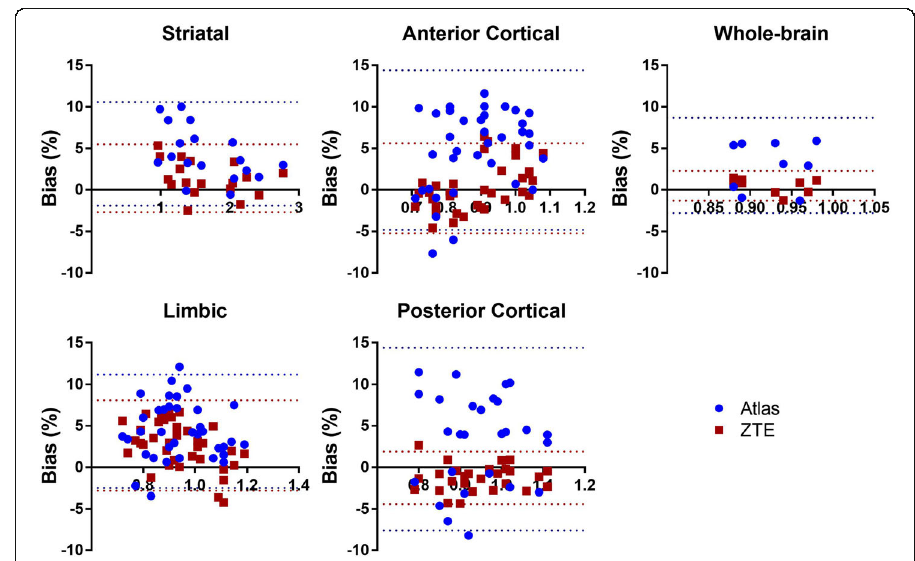
Fig. 8 SUVR bias plots of ZTE-AC and atlas-AC compared to 68 Ge-AC for different brain regions. Dashed lines represent confidence intervals associated to both